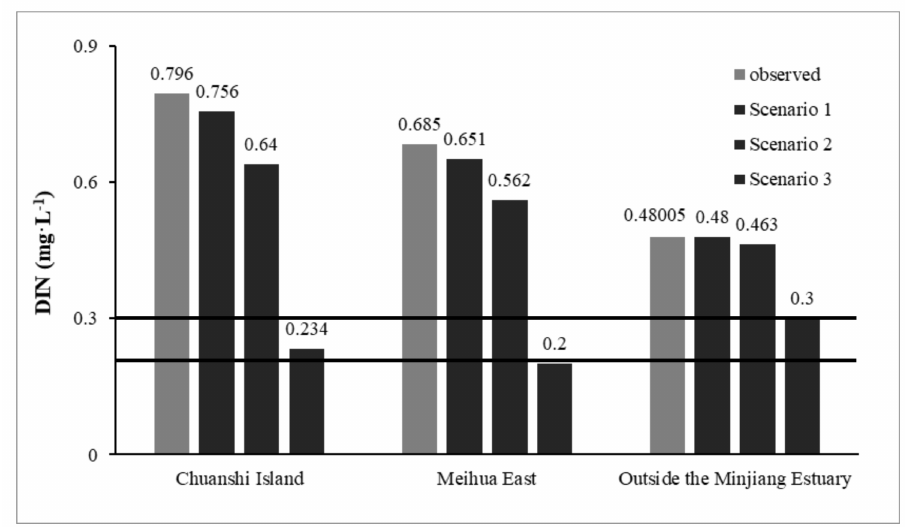
Figure 10. Prediction results after reduction of pollution sources in the land area of the Minjiang